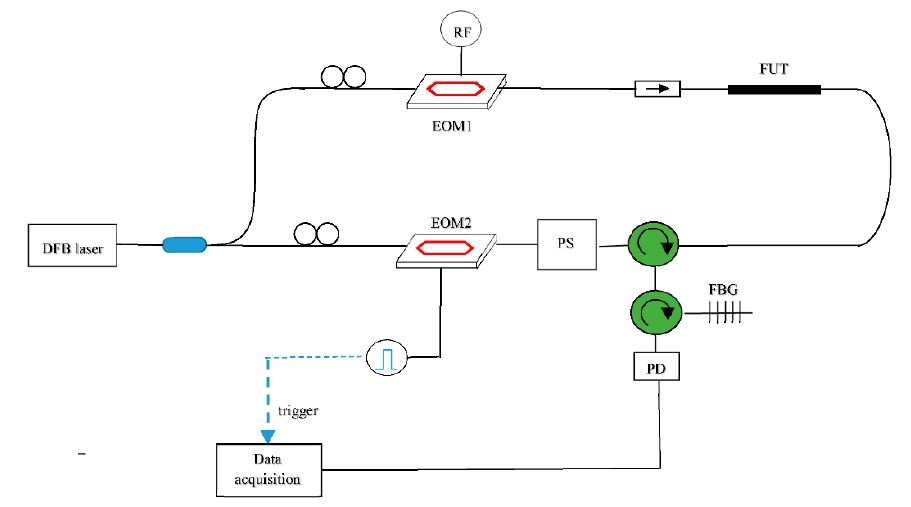
Figure 2. Conventional BOTDA configuration. PS: polarization scrambler; FBG: fiber Bragg grating. EOM: Electro-optic modulator. PD: photodetector.